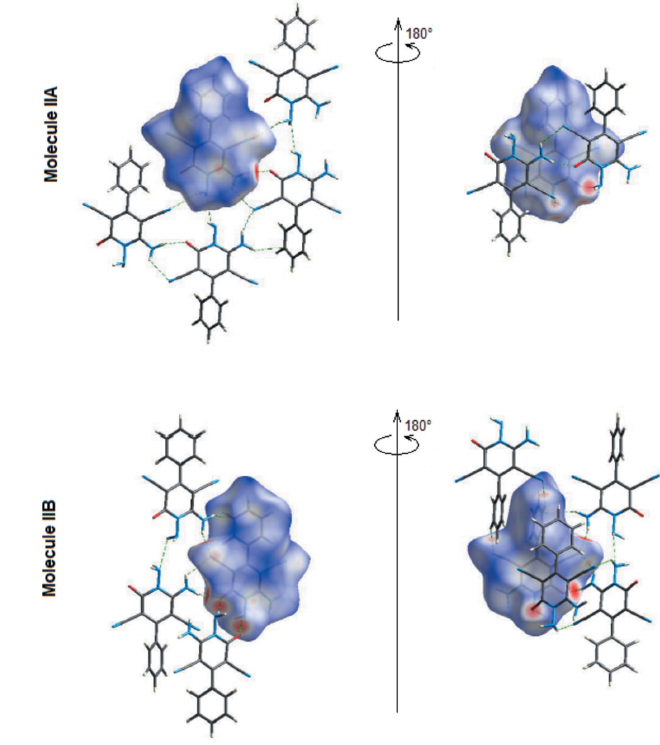
Figure 8 Front and back views of the three-dimensional Hirshfeld surface of molecules (IIA) and (IIB) plotted over d norm in the range (cid:5) 0.5399 to 1.2085 a.u. for (IIA) and in the range (cid:5) 0.5388 to 1.1921 a.u. for (IIB).